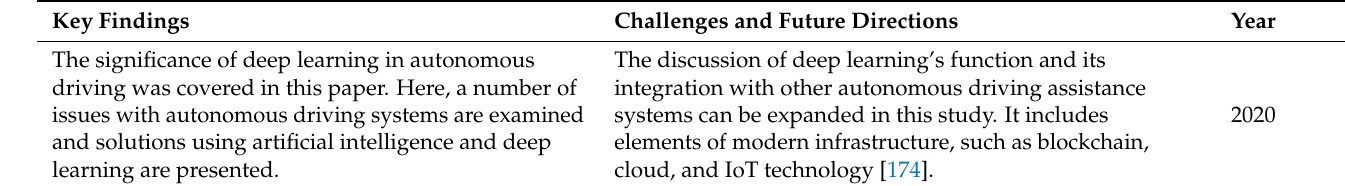
Table 2. Challenges and future directions of modern intelligent vehicle